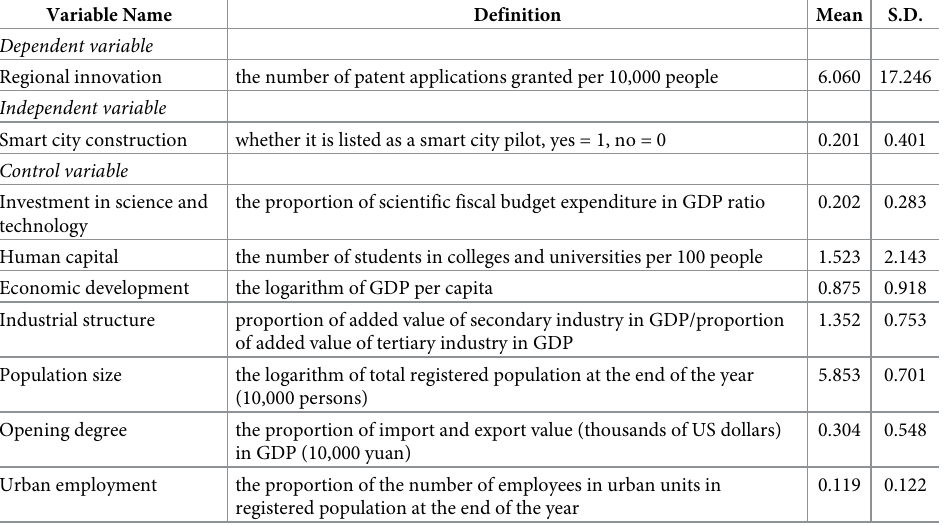
Table 1. Definition and descriptive statistics of the variables.